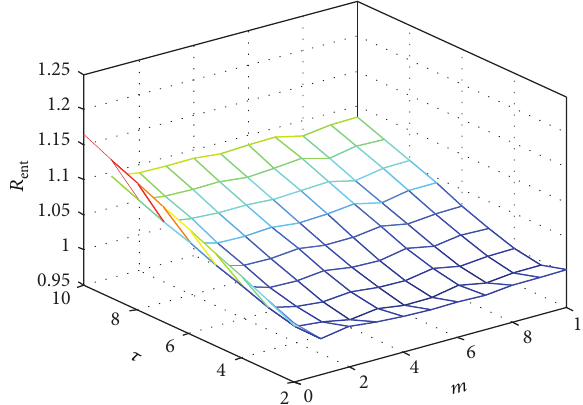
Figure 2: Plots of the ER for uranium resource price monthly data